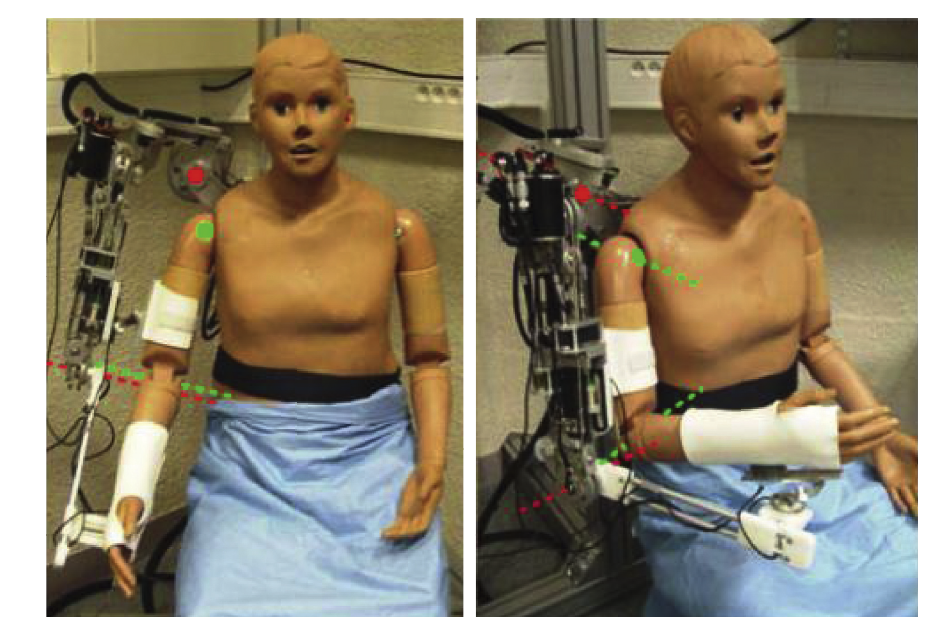
Figure 3: Manikin-exoskeleton